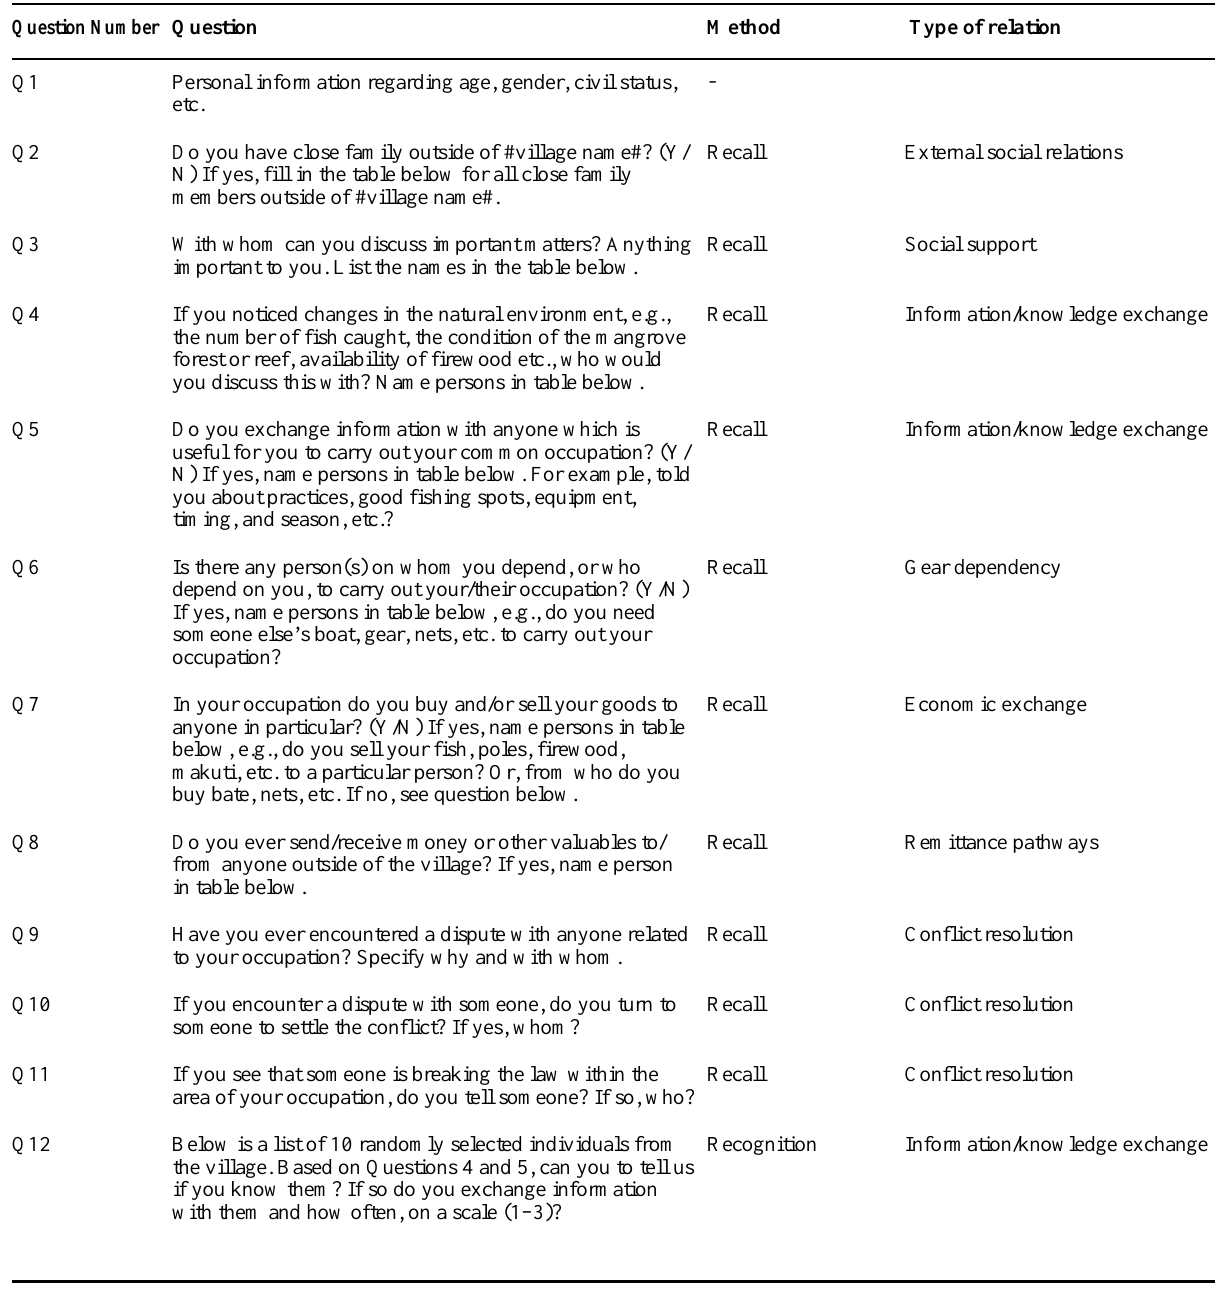
Table 1. Overview of questions put to each respondent for collection of network data. Question Number